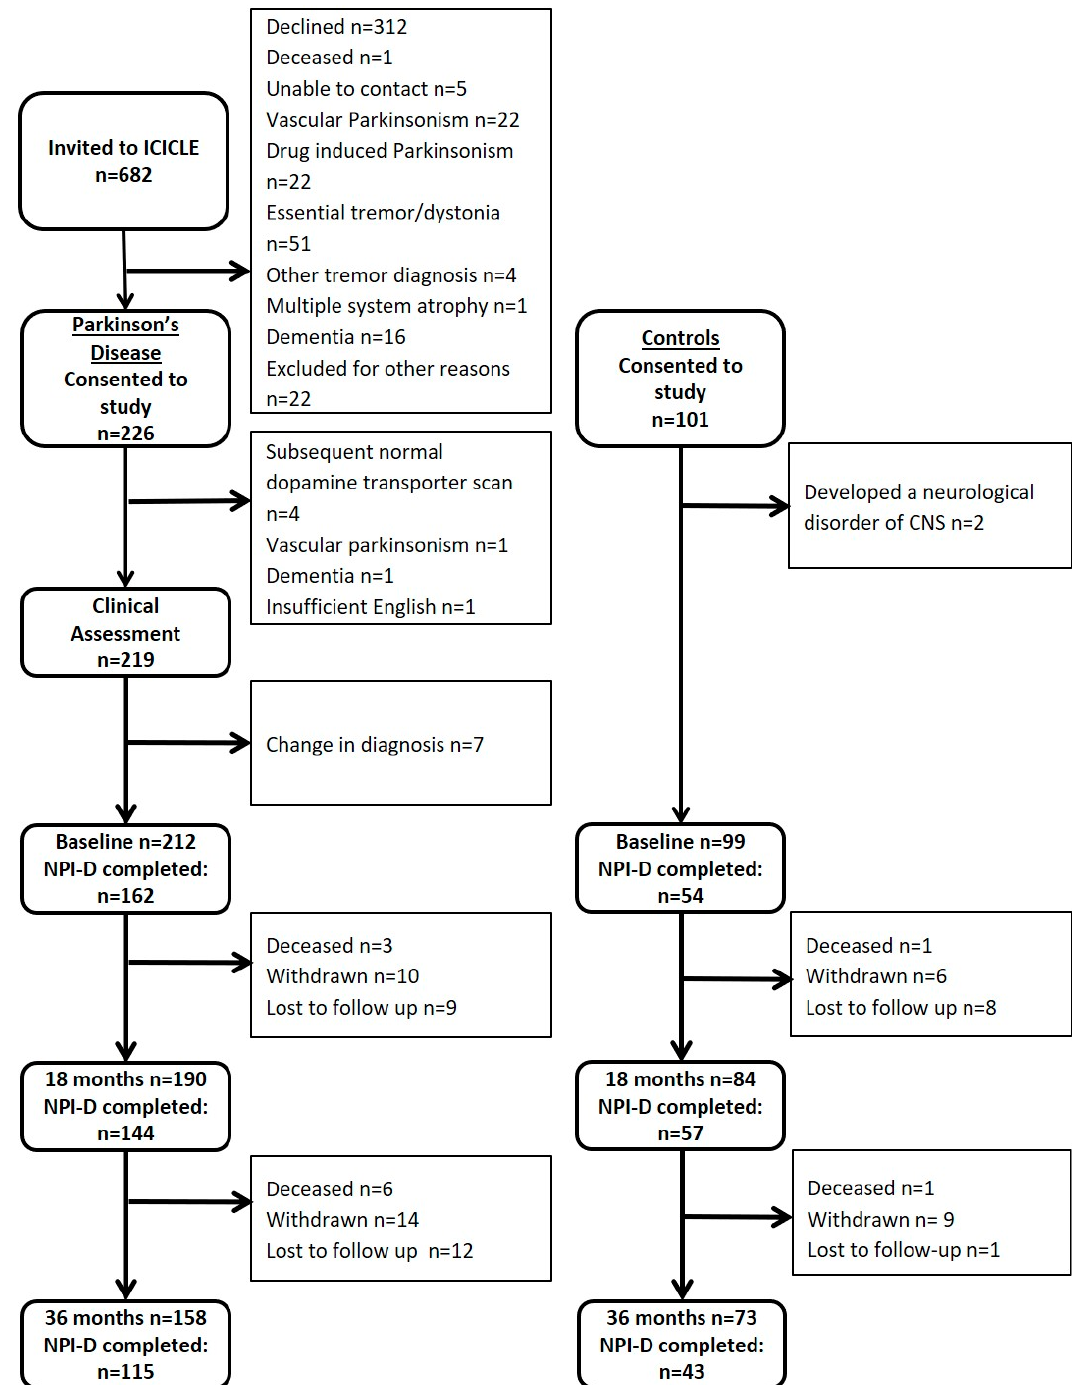
Figure 1. Flowchart outlining participants.